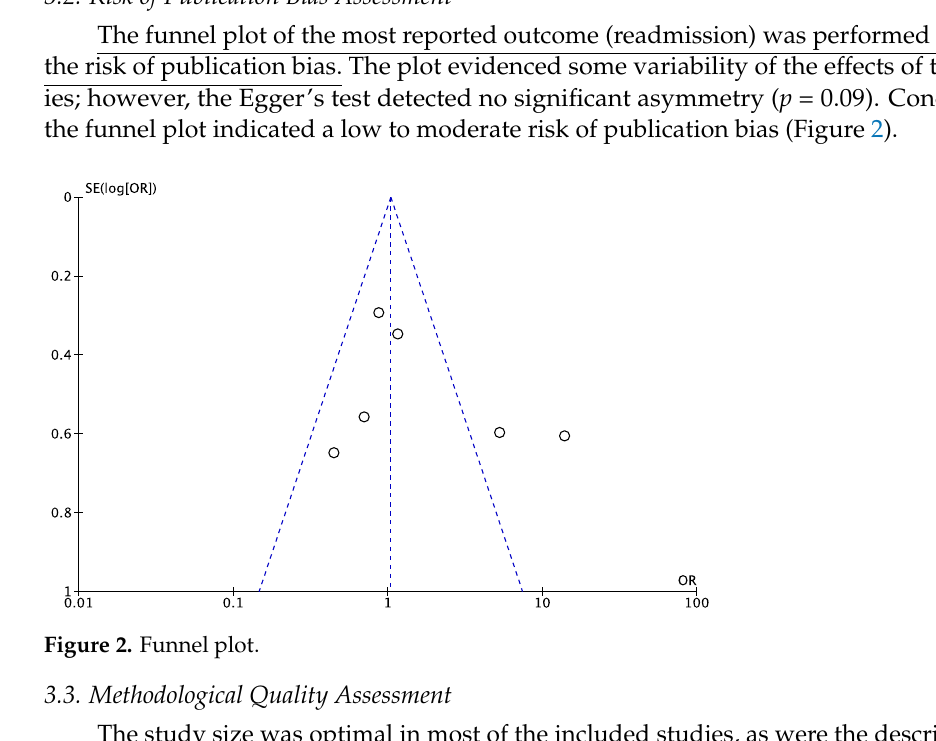
Figure 1. Flow chart of the literature search.